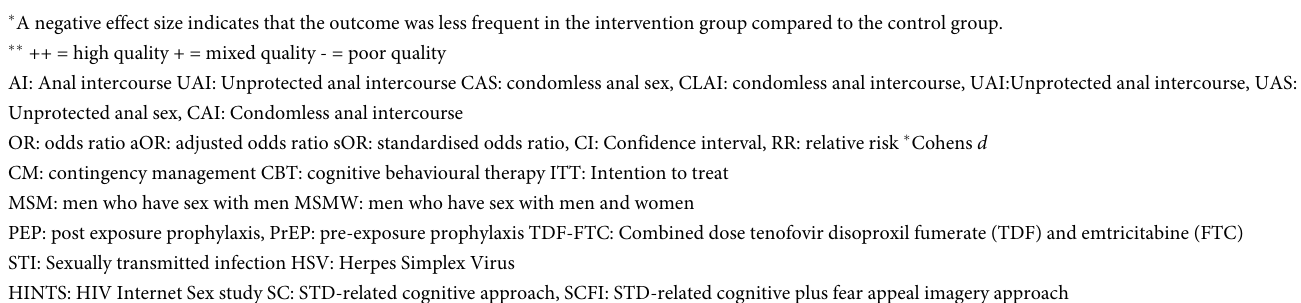
Calculated Standardised Effect Sizes for chosen outcomes Score ��